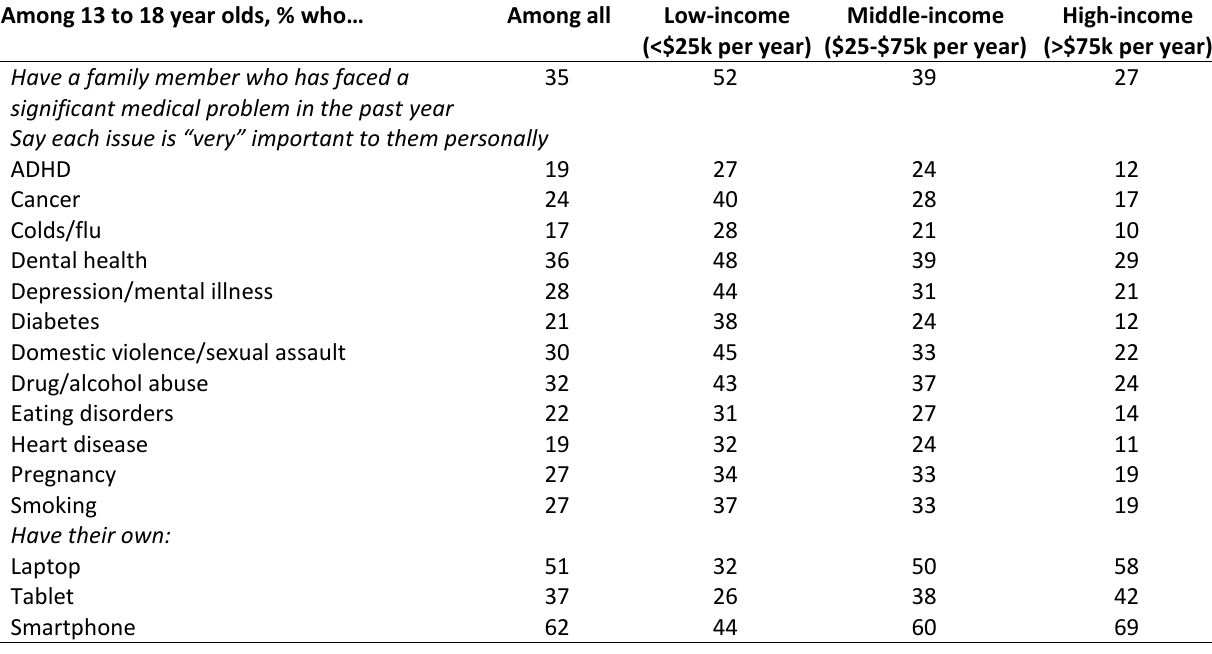
Table 2. Differences in health concerns and ownership of digital devices by family income. Among 13 to 18 year olds, % who… Among all